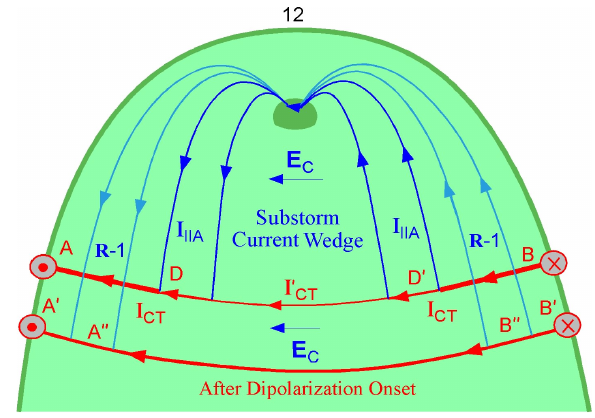
Fig. 7b. (b) depicts the CECL model after the dipolarization onset. Energy flow to power the CECL model after the dipolarization onset is discussed in Sect.